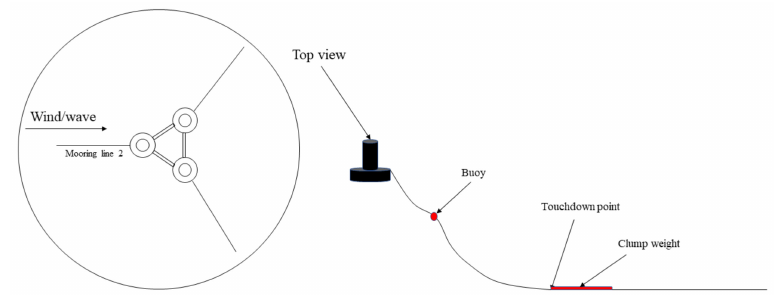
Figure 6. Schematic diagram of mooring.